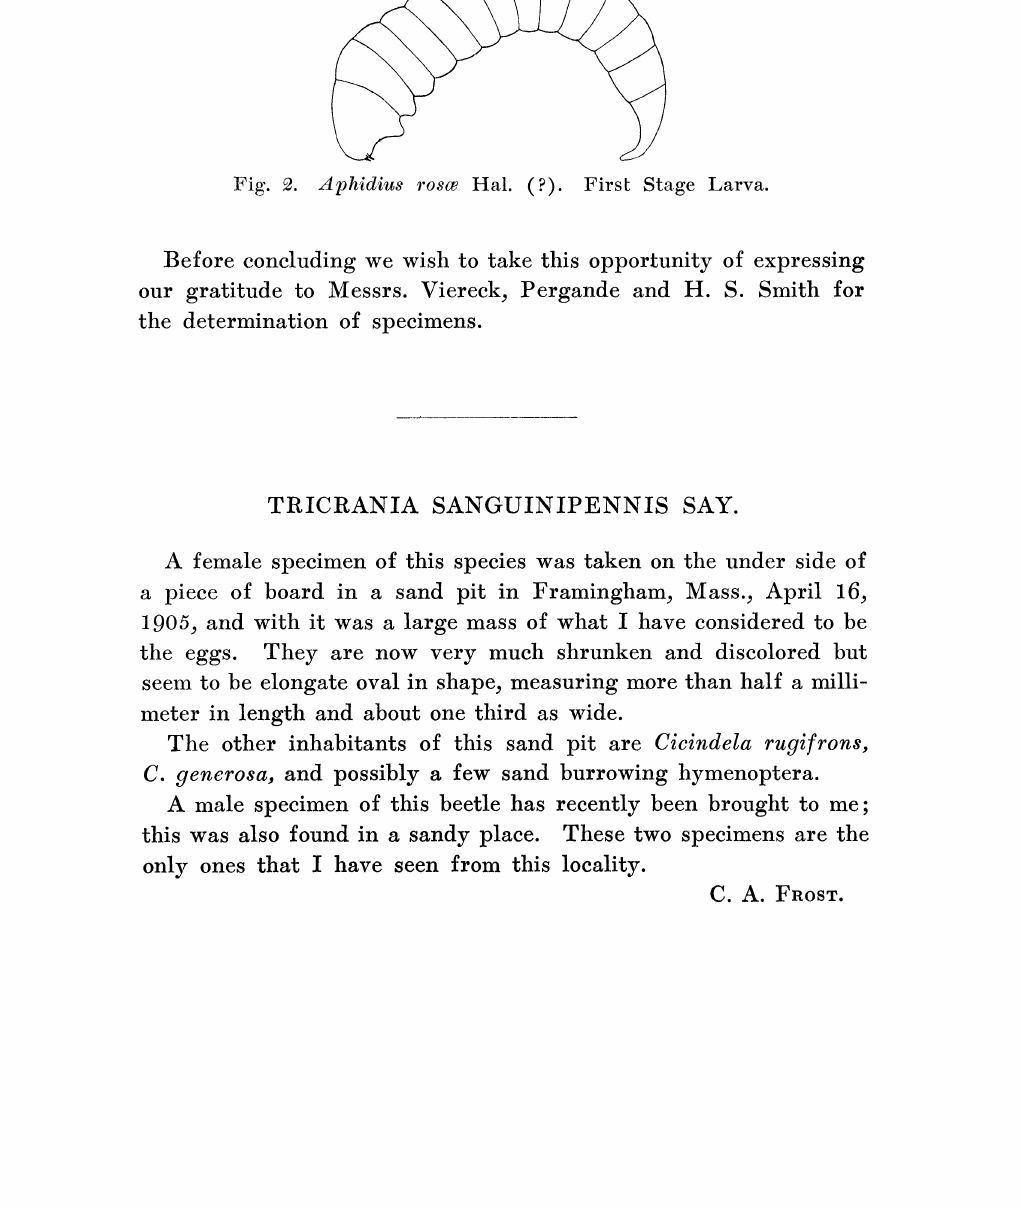
4phidius rosce Hal. (?). First Stage